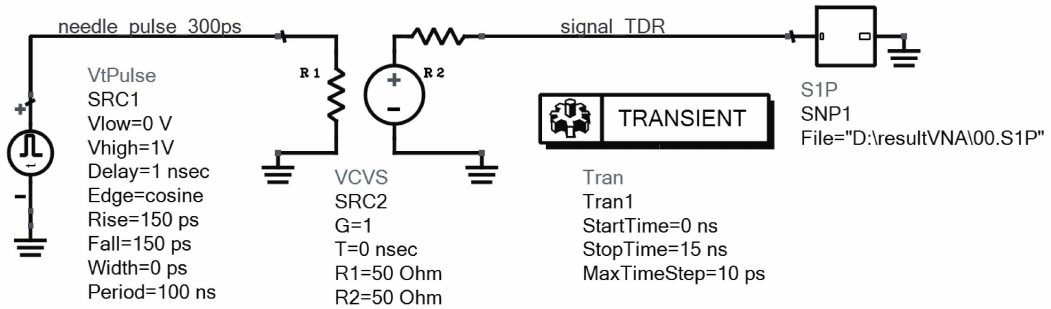
Figure 5. Connection diagram of the circuit elements in the ADS program for signal analysis in the time domain for the S11